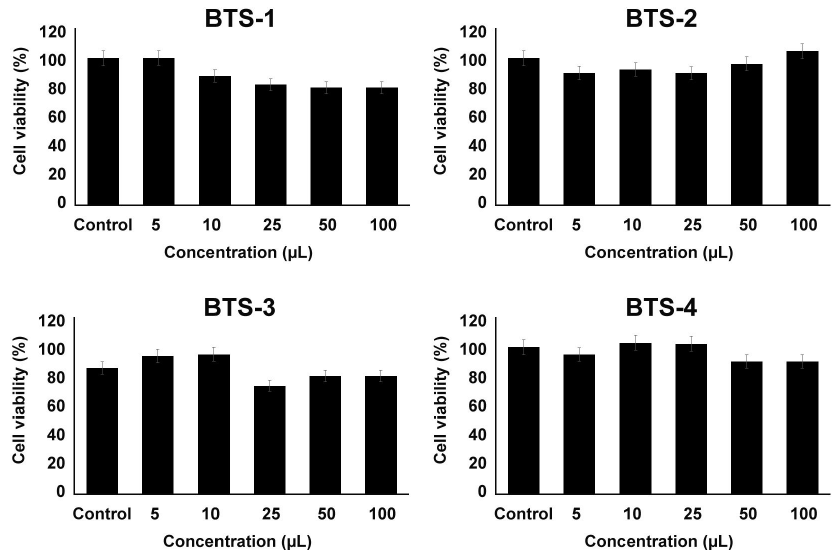
Figure 6. Effect of scaffolds at different concentrations on 3T3 cell